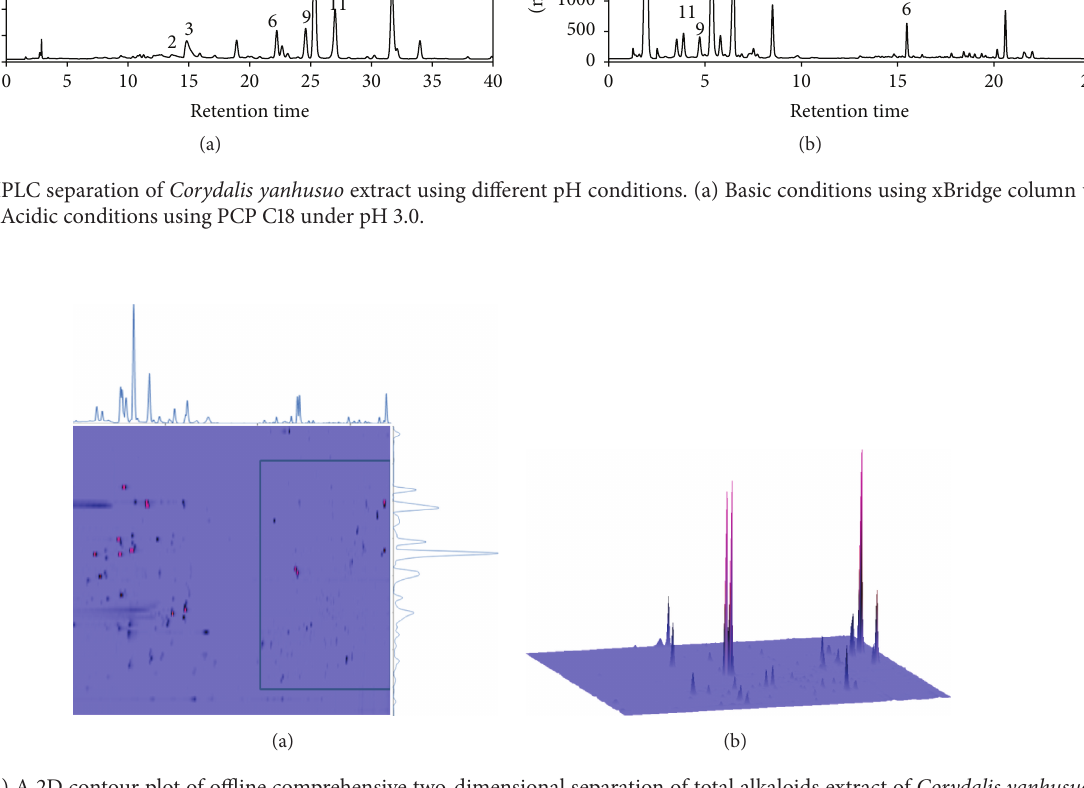
Figure 3: (a) A 2D contour plot of offline comprehensive two-dimensional separation of total alkaloids extract of Corydalis yanhusuo . The top chromatograms denote separation with pH 3.0, and the right chromatograms denote separation with pH 10.5. (b) 3D demonstration of two-dimensional separation chromatogram. The 𝑋 -axis is the retention time with pH 3.0, the 𝑌 -axis is the retention time with pH 10.5, and the 𝑍 -axis is the absorption at 280